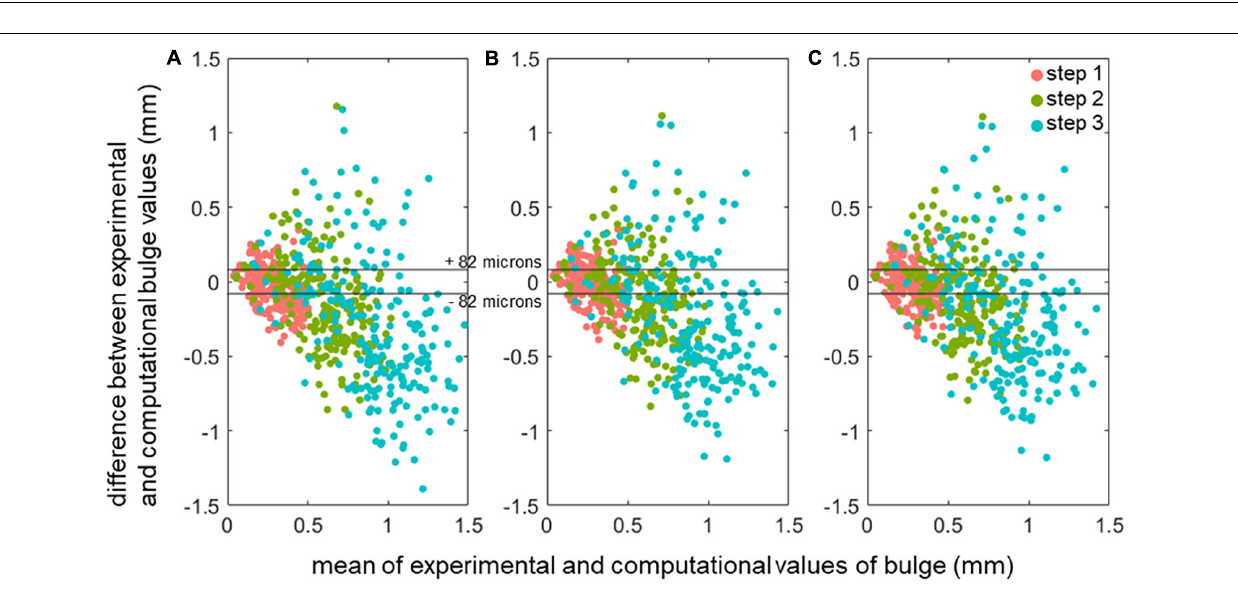
FIGURE 7 | Agreement of the in vitro and in silico load measurements, for each specimen and each model type. (A) Models using 1-to-1 calibration of the compressibility value. (B) Models using the average compressibility value.